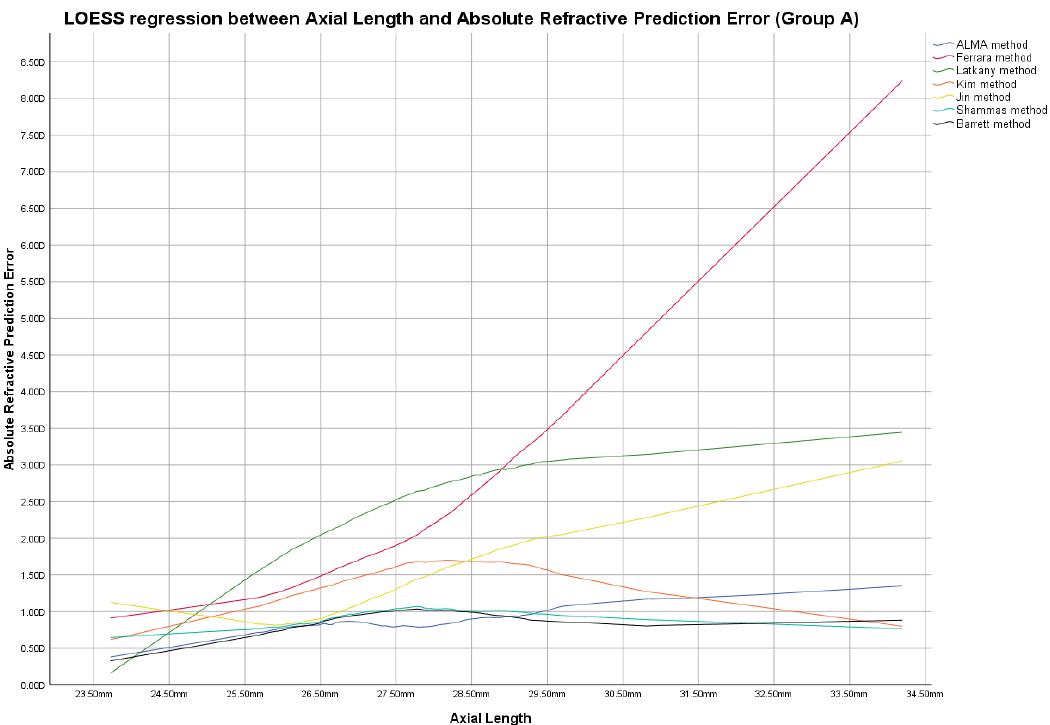
Figure 2. Locally estimated scatterplot smoothing (LOESS) curve between refractive prediction errors generated for each examined formula and the related axial length value. (Group A).